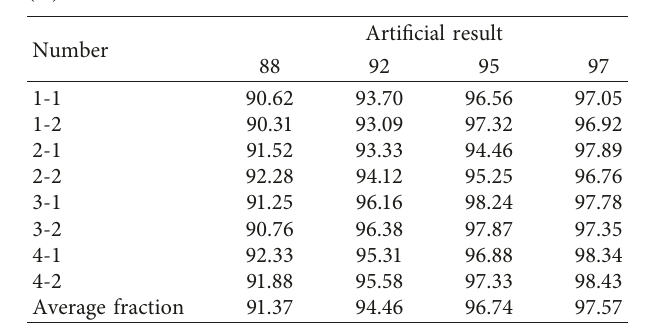
Figure 5: Constitution diagram after binarization preprocessing. Table 3: Results on the cube texture fraction based on pit etching (%).